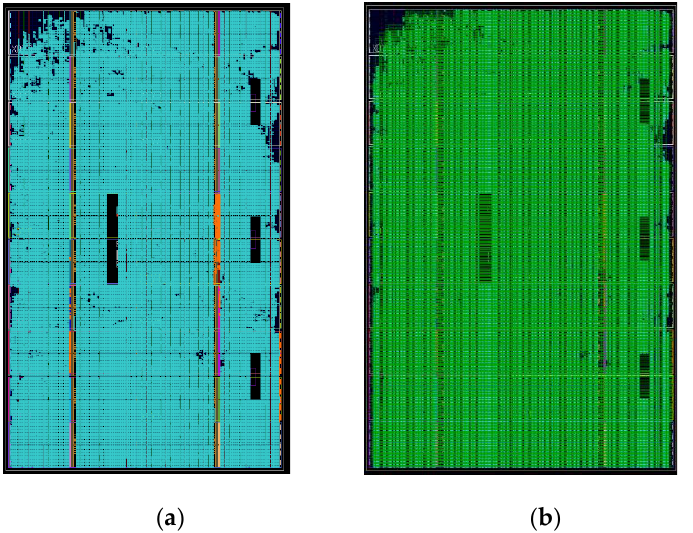
Figure 16. Resource layout and routing diagram. ( a ) Resource layout. ( b ) Resource routing diagram.